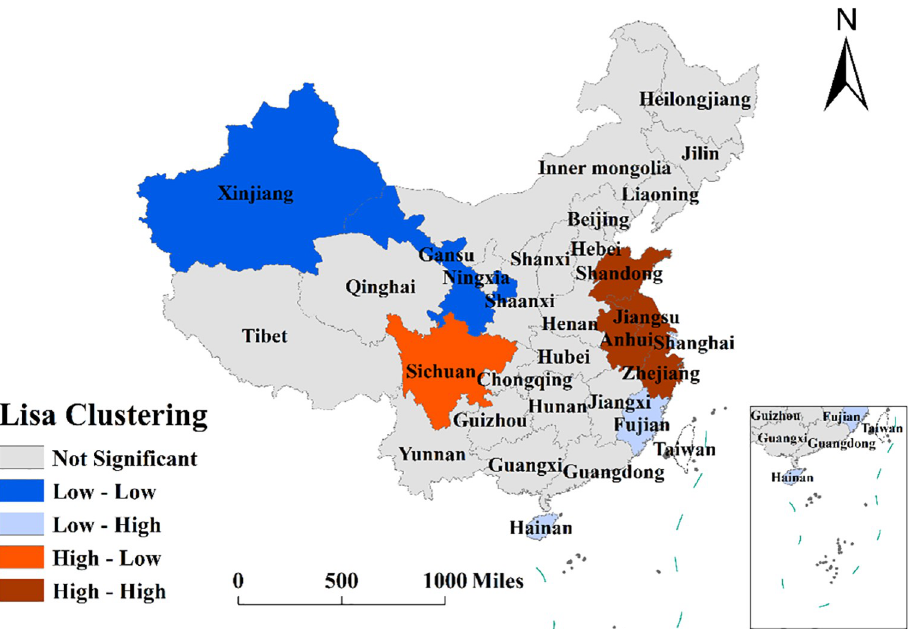
Fig 6. LISA concentration of novel coronavirus network concern. Source: The primitive base map from the website of the Ministry of Natural Resources of China (http://bzdt.ch.mnr.gov.cn/) was plotted by ArcGIS 10.2 software (ESRI 1 ), and its Drawing Review Number is GS (2016)